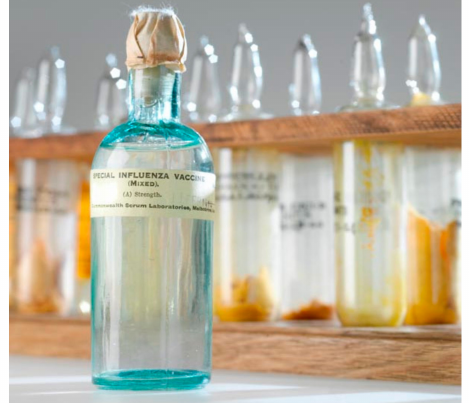
Figure 2. Mass grave of victims of the 1918 influenza pandemic in Apia, Samoa. Photo by Dr. Kevin Palmer.